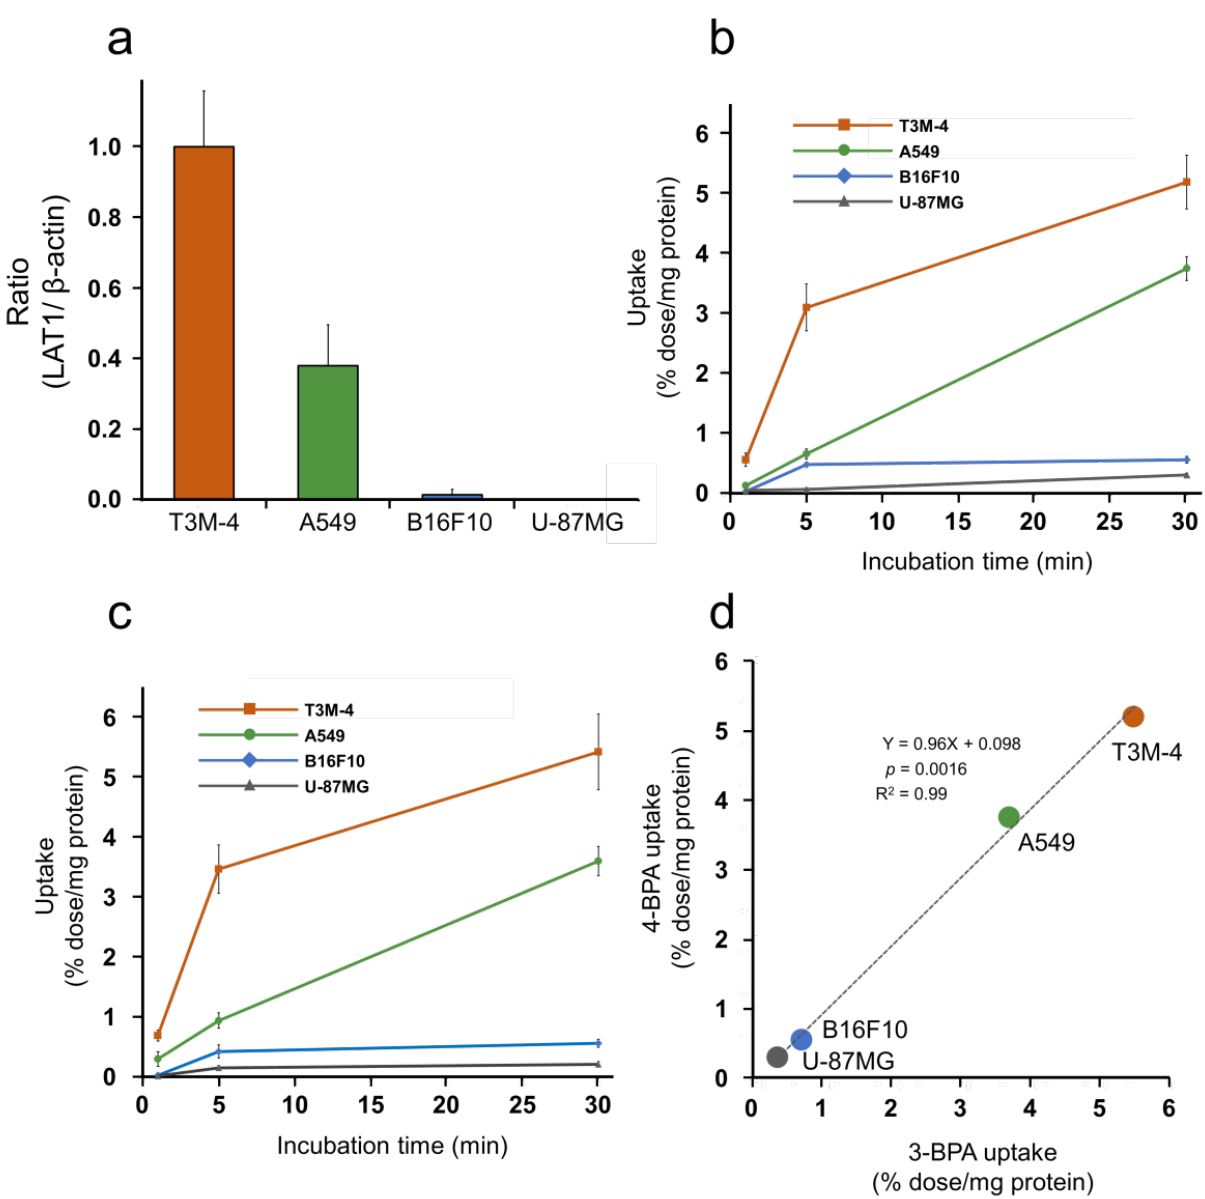
Figure 2. In vitro cell uptake of 3-BPA and 4-BPA in cancer cells with various LAT1-expression. ( a ) The LAT1/ β -actin ratio of each cell calculated from the expression levels of LAT1 and β -actin obtained by Western blotting and standardized to a value of 1 for T3M-4. ( b , c ) LAT1-specific accumulation (the difference in accumulation between the inhibitor group and the noninhibitor group) in T3M-4, A549, B16F10, and U-87MG cells after 1, 5, and 30 min incubation with 3-BPA ( b ) and 4-BPA ( c ). ( d ) The relationship between the uptake (% dose/mg protein) of 3-BPA and 4-BPA at 30 min incubation with a simple linear regression. Statistical analyses of LAT1-specific accumulation of 3-BPA ( b ) and 4-BPA ( c ) were shown in Supplementary Tables S3 and S4, respectively.